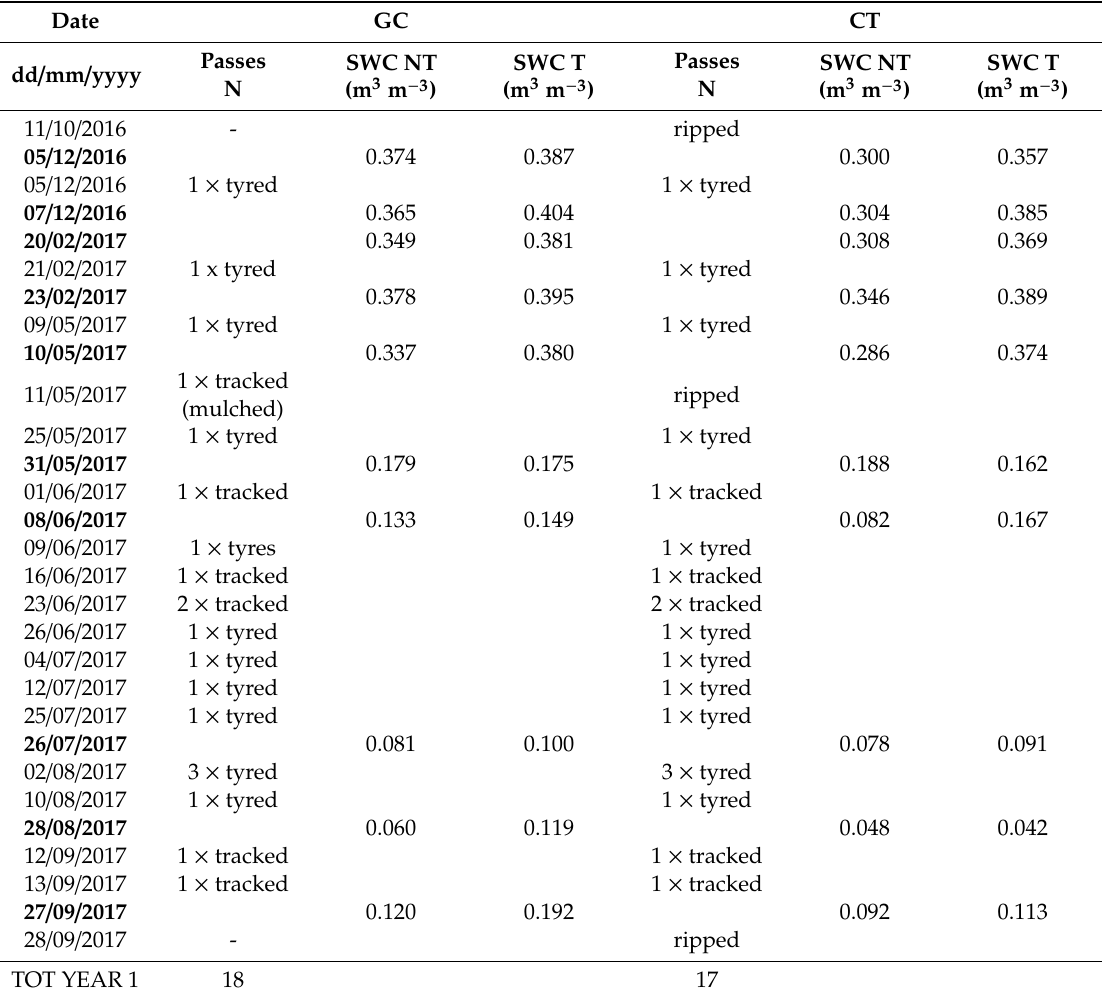
Table 2. Dates in bold indicate field measurements: values of soil water content (SWC, m 3 m − 3 ) measured in the conventional tillage plot (CT) and in the controlled grass (GC) treatments in track (T) and no-track (NT) positions are indicated. Other dates indicate the passage of tractors in vineyard (the number of passages and if passages were tyred or tracked) and dates of execution of field operations (ripping and / or mulching).